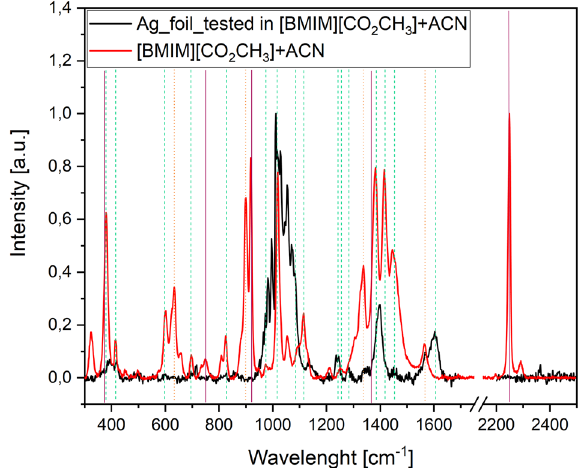
Fig. 4 Raman spectra of the [BMIM][CO 2 CH 3 ] electrolyte and working electrode after test. The electrolyte was composed by [BMIM][CO 2 CH 3 ] in ACN (red line). The working electrode was after test (black line). Vertical lines mark intensity peaks related to acetate anion (dot orange line), BMIM cation (dashed green line) and fi nally ACN (solid purple line).